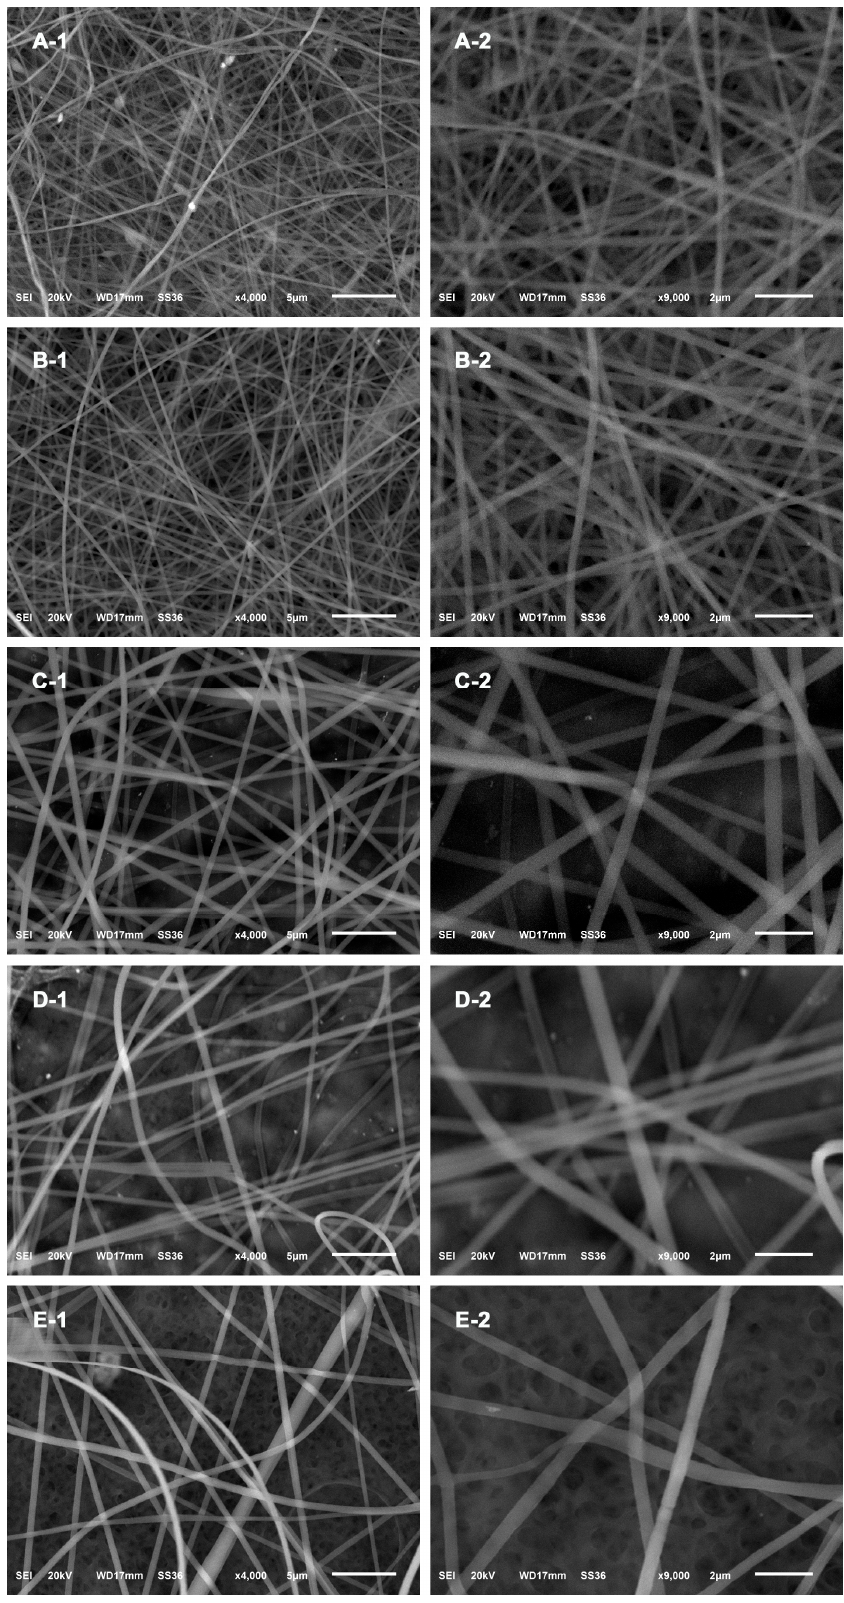
Figure 5. SEM images of SG-Ag/PAN electrospun fibers prepared with different feed ratios of PAN and SG to Ag NPs: ( A ) 1:1:4, ( B ) 3:1:4, ( C ) 5:1:4, ( D ) 7:1:4, and ( E ) 9:1:4.